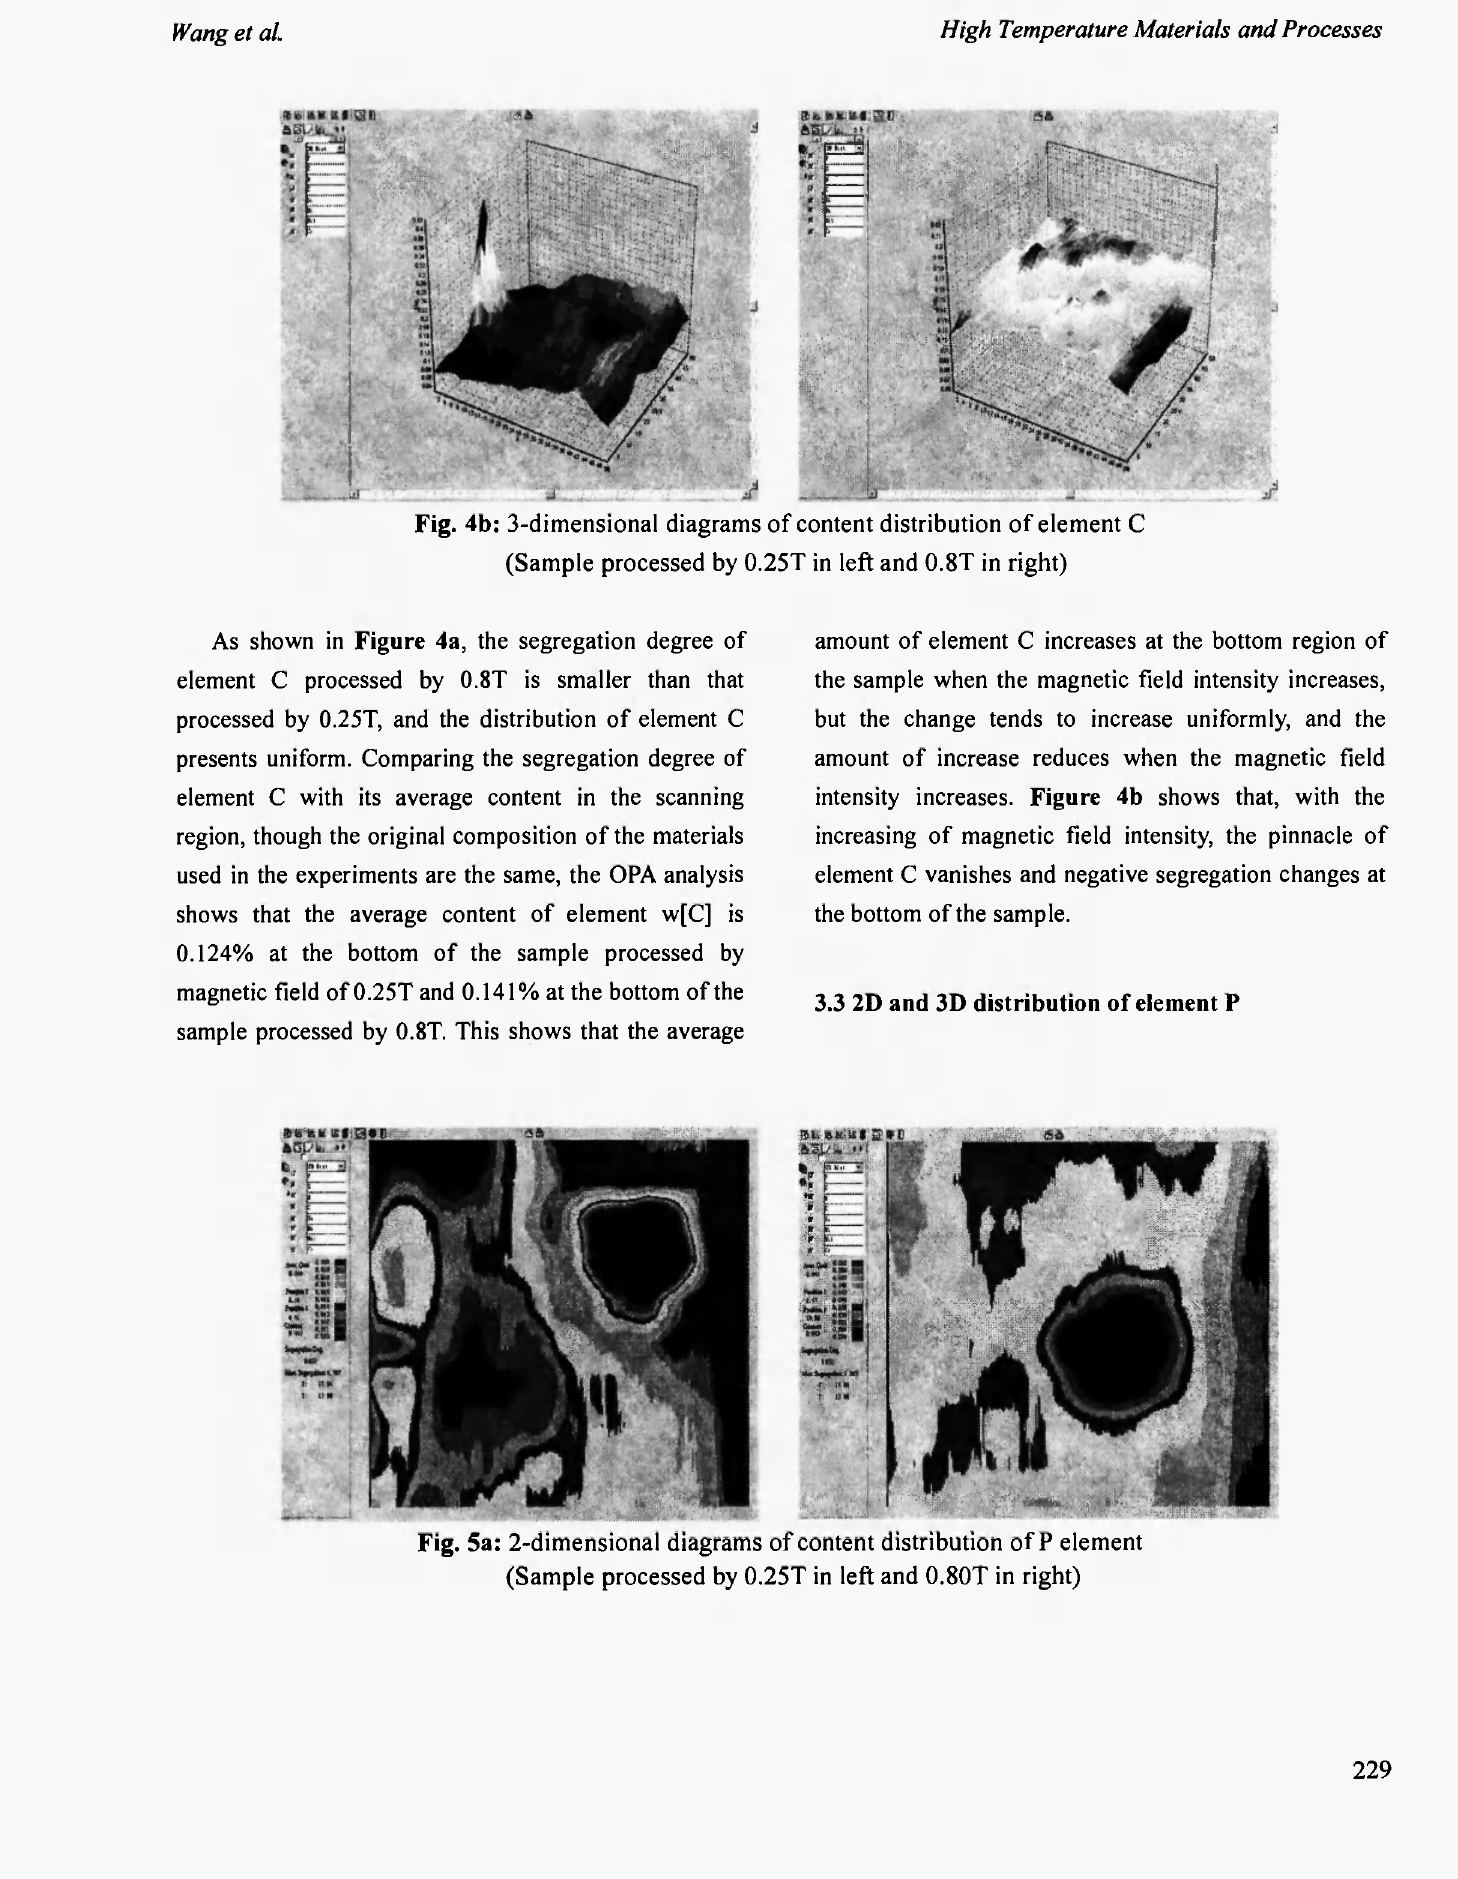
Fig. 5a: 2-dimensional diagrams of content distribution of Ρ element (Sample processed by 0.25T in left and 0.80T in